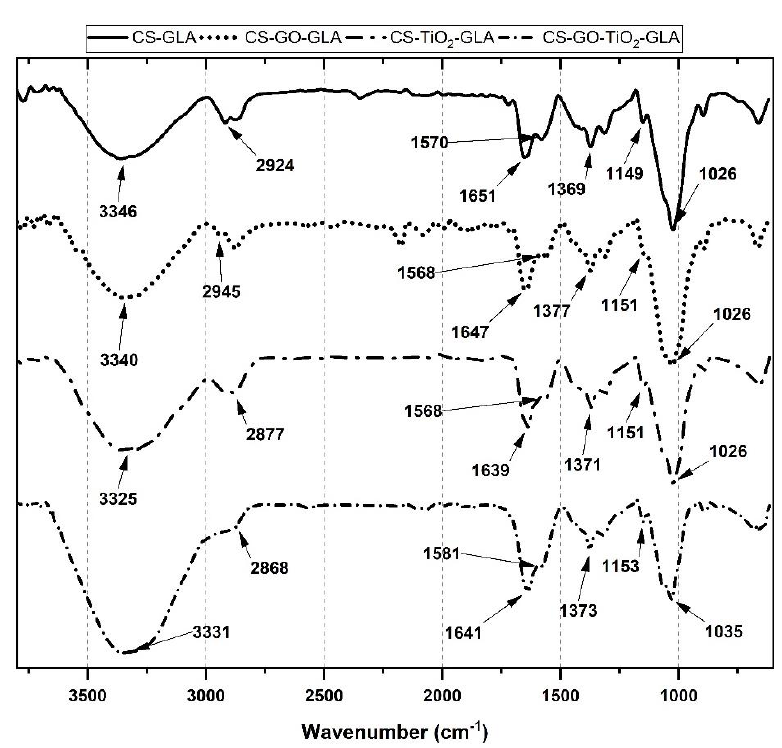
Figure 3. FTIR images of the different nanocomposite beads of CS-GLA, CS-GO-GLA, CS-TiO 2 -GLA, and CS-TiO 2 -GO-GLA).